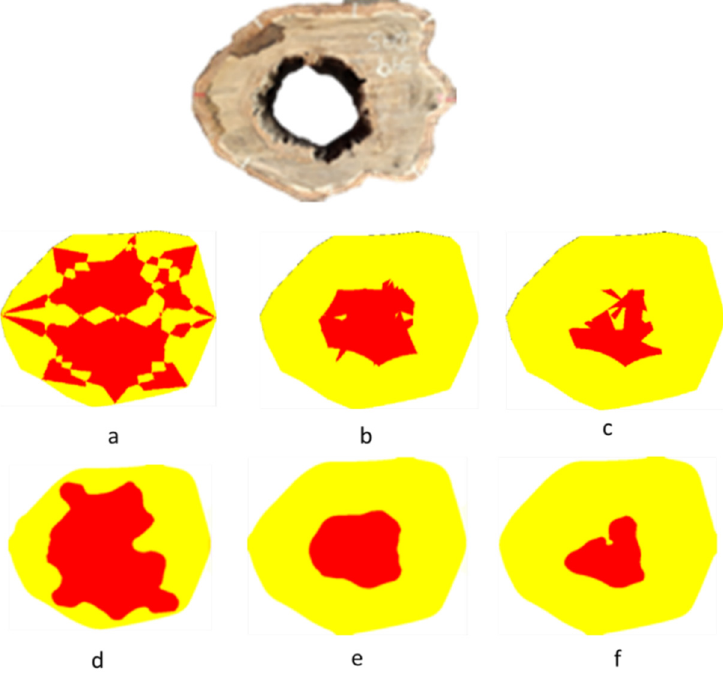
Figure 11. Example of disc photography and tomographic images obtained without filter application with ISD algorithms ( a ), Ellipses with compensation ( b ) and Ellipses without compensation ( c ) and with filter application with ISD algorithms ( d ), Ellipses with compensation ( e ) and Ellipses without compensation ( f ).